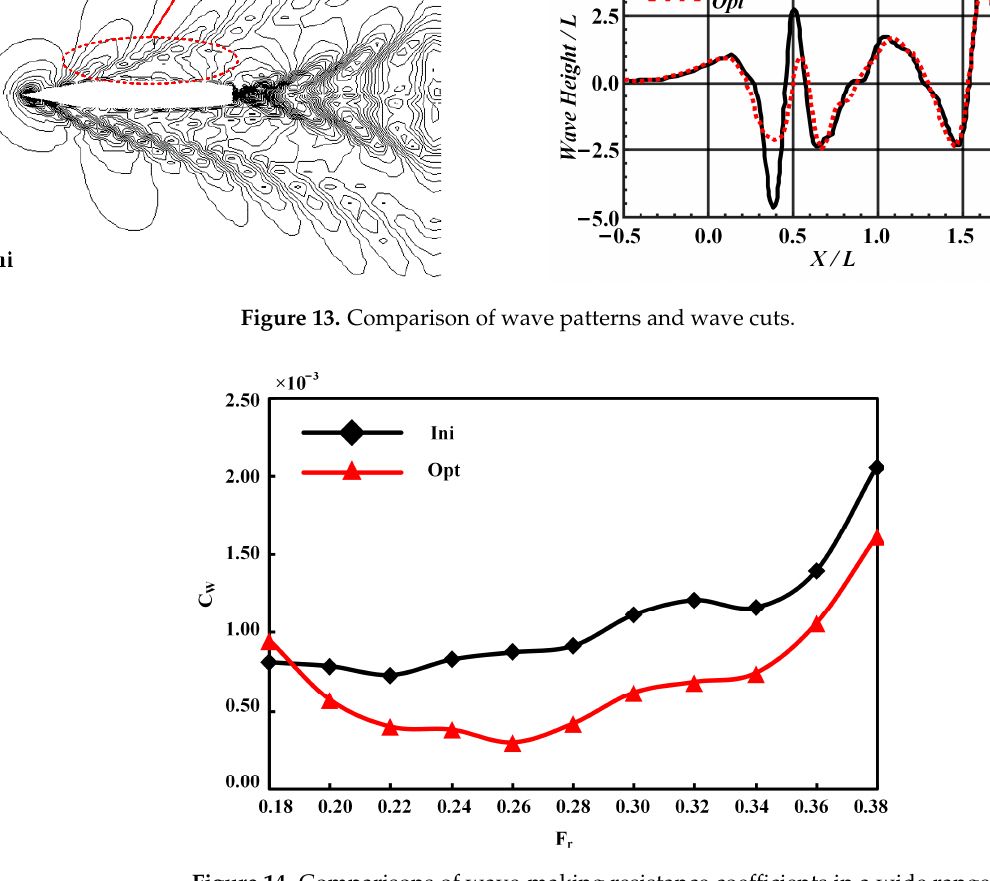
Figure 14. Comparisons of wave-making resistance coefficients in a wide range of speed between initial and optimal hull form.